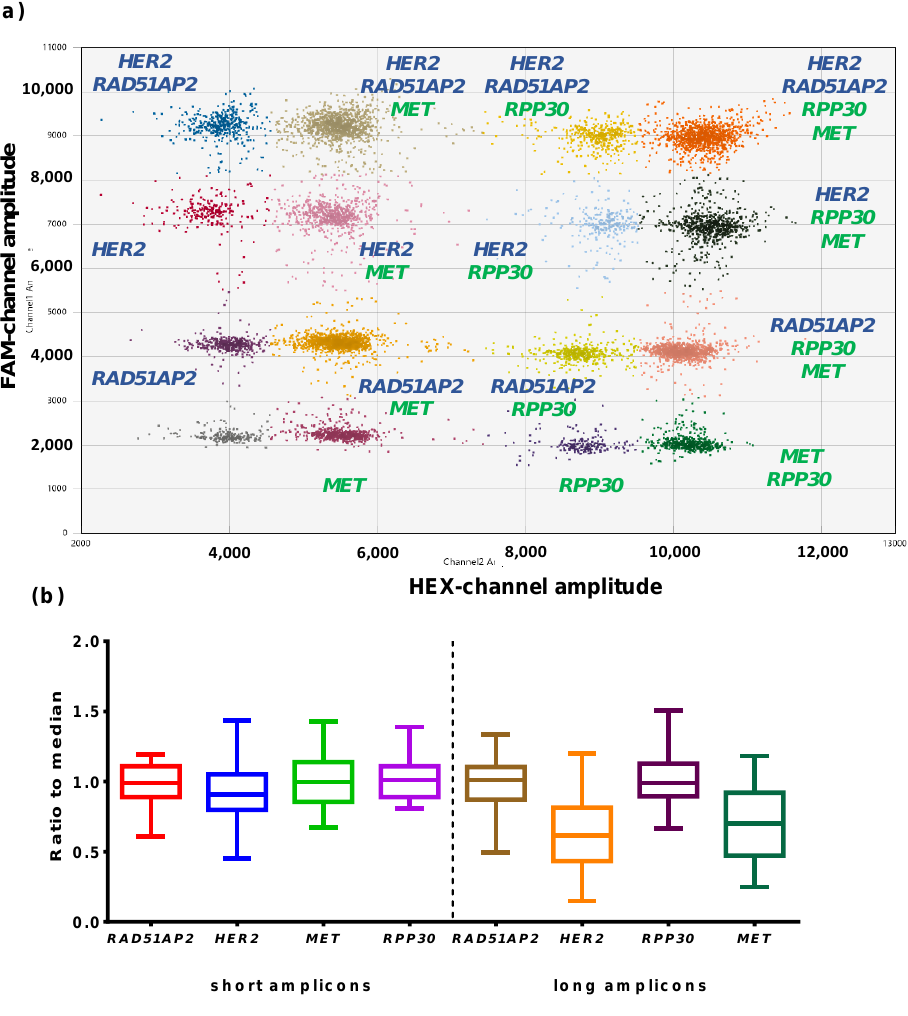
Figure 5. Results of pilot ddPCR with DNA from NSCLC FFPE samples. ( a ) 2D ddPCR plot. X-axis represents the amplitude of HEX-channel, Y-axis represents amplitude of FAM-channel. Loci are marked near respective clusters. ( b ) Tukey box-and-whiskers plot, X-axis represents genes, Y-axis represents the ratio of gene concentration to median concentration for both reference loci. Data for long amplicons are presented at the right side of the plot, data for short amplicons are presented at the left side.